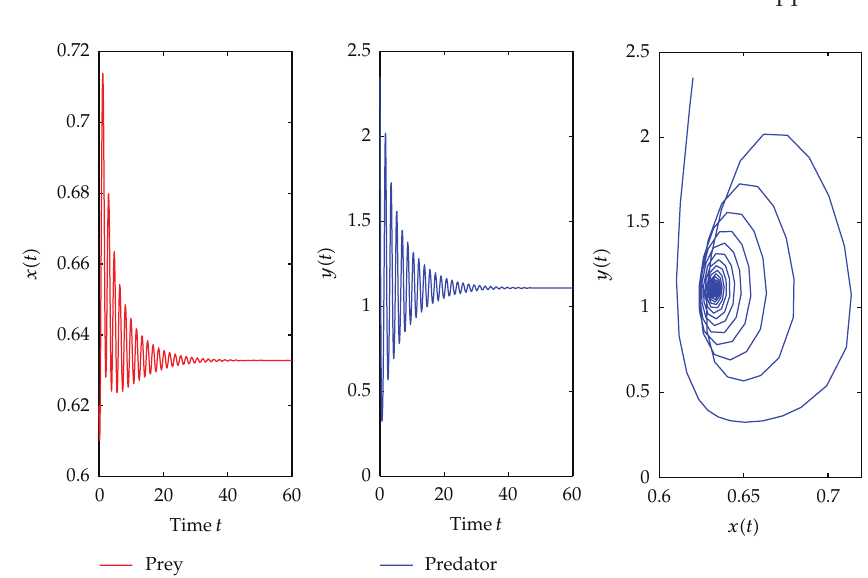
Figure 1: E ∗ is stable for τ 1 (cid:5) τ 2 (cid:5) τ (cid:5) 0 . 4 < τ 0 (cid:5) 0 . 4292 with initial value 0.62,2.35.